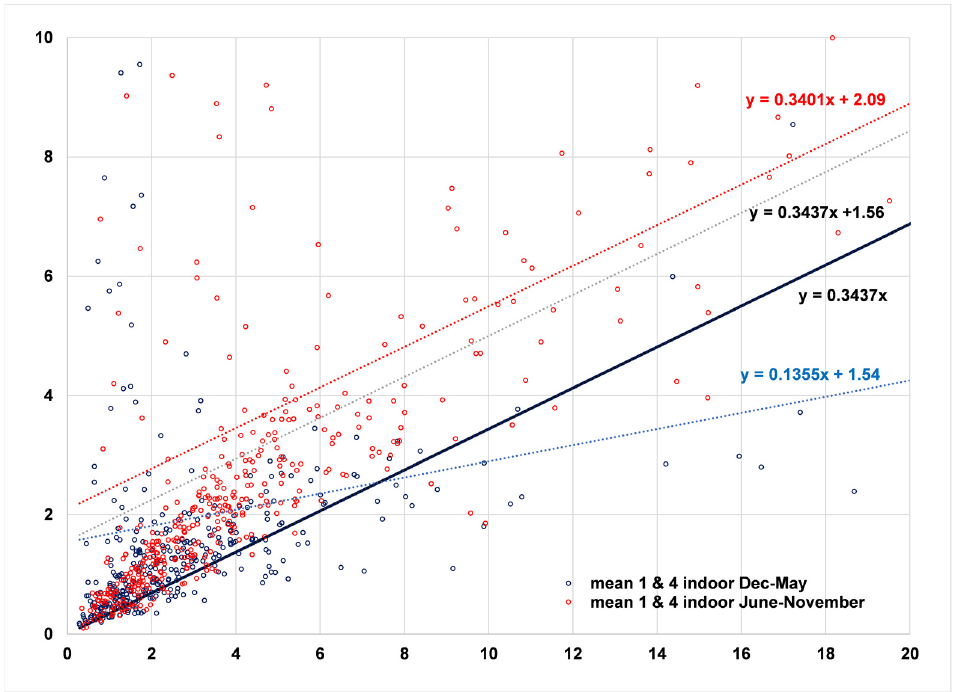
Figure 17. Regressions of Oakmont indoor PM 2.5 measurements on outdoor values. The equation for the combined data is y = 0.3437x + 1.56 µg/m 3 (light black dashed line) and the resulting upper boundary of the Forbidden Zone is y = 0.3437x (thick black line passing through the origin). The equation for the summer–fall data (red) is 0.3401x +1.56. The equation for the winter–spring data (blue) is 0.1335 + 1.54.